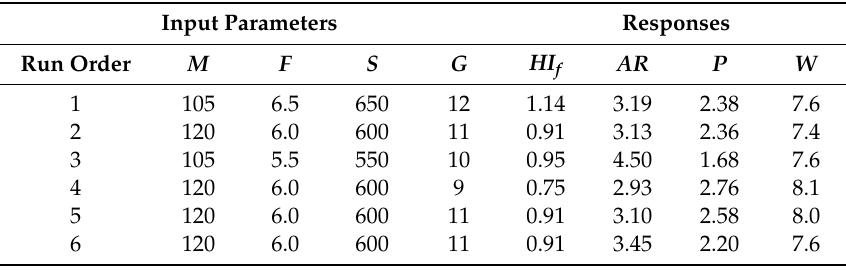
Table 2. The design and response parameters.